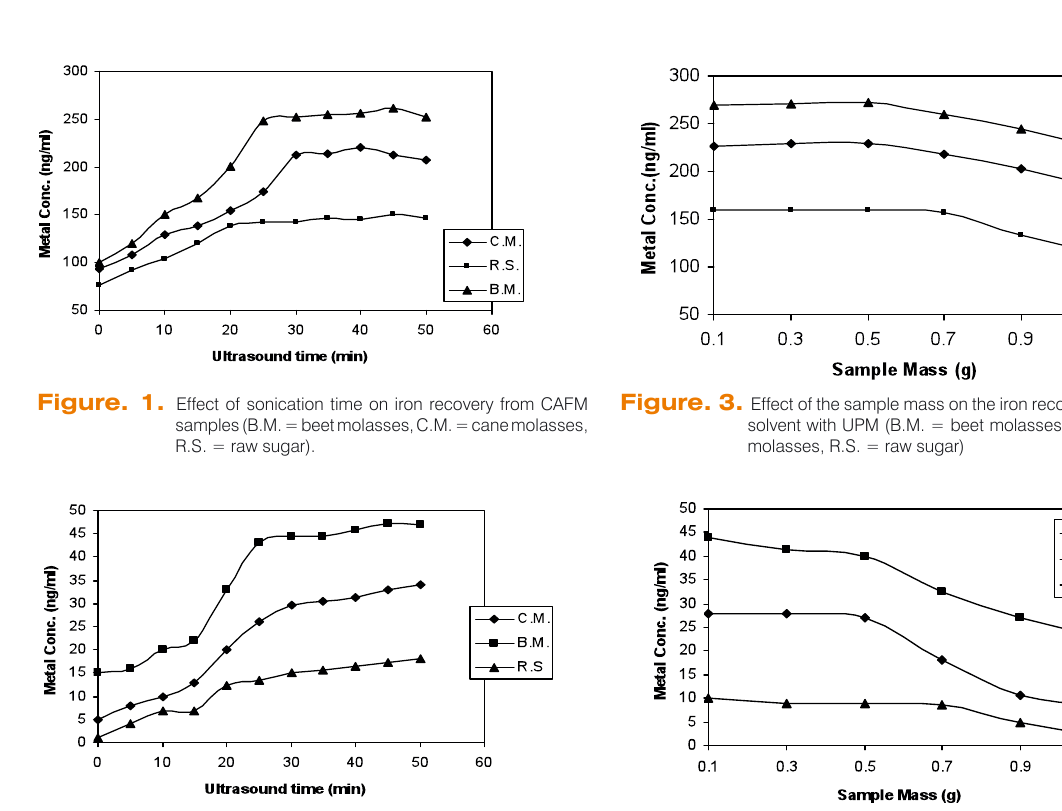
Figure. 4. Effect of the sample mass on manganese recovery from acid solvent with UPM (B.M. = beet molasses, C.M. = cane molasses, R.S. = raw